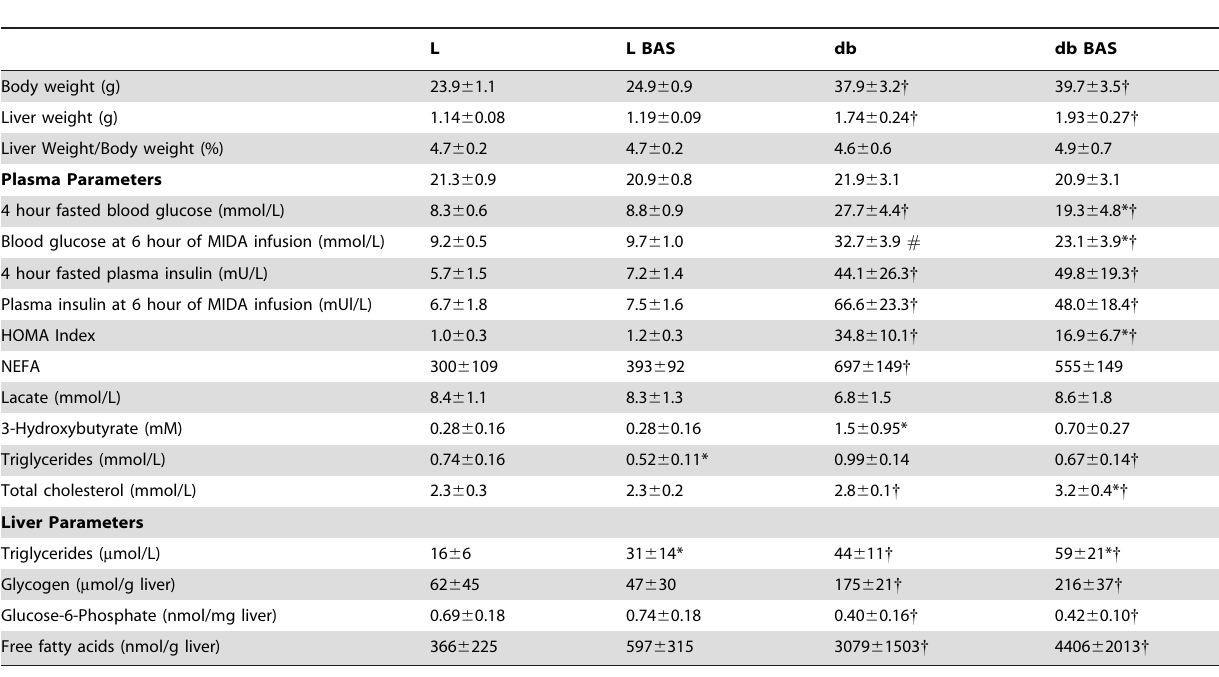
Table 1. The effects of bile acid sequestration (BAS) on morphological, plasma and hepatic parameters in lean and diabetic